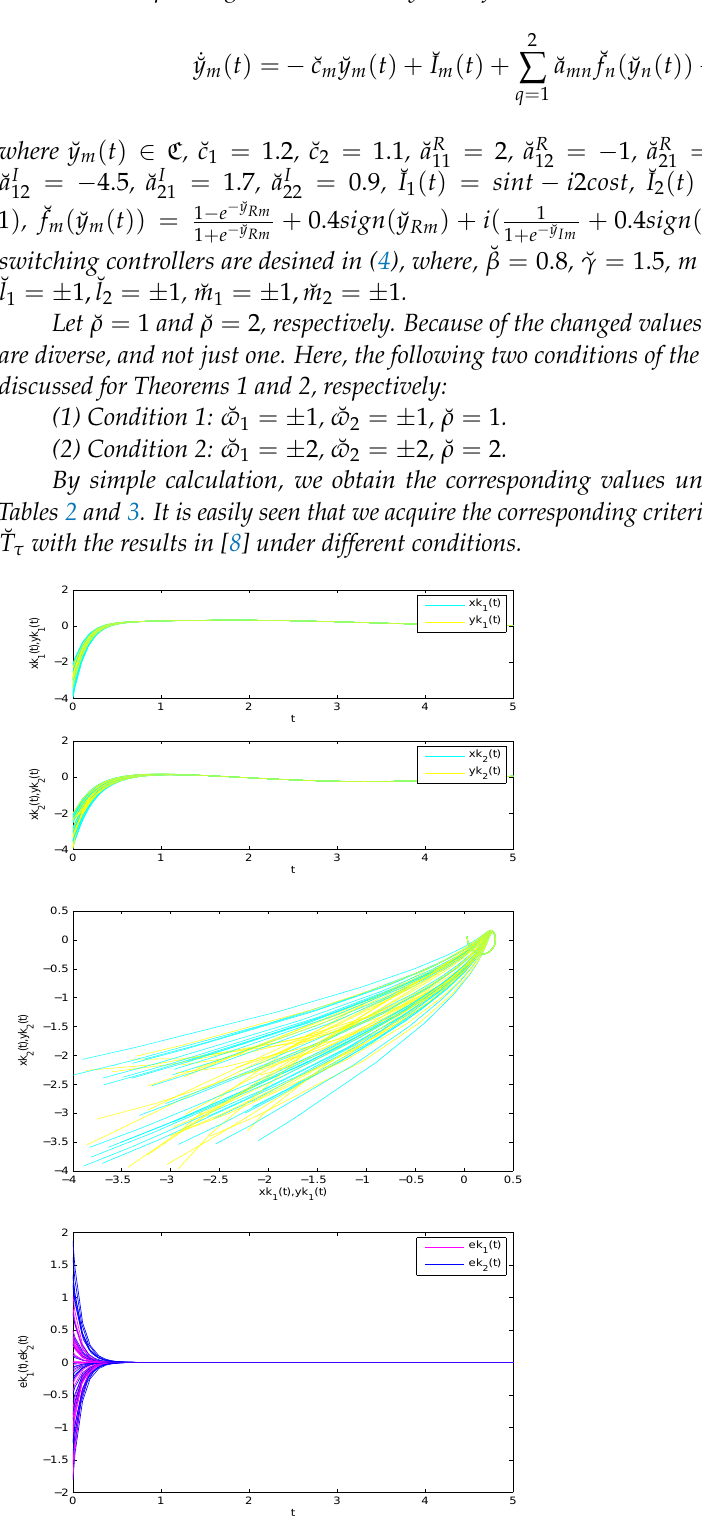
Figure 4. Instantaneous error states for the K part between for the variable ˘ x of (18) and ˘ y of (19) under 30 random initial values for asymptotical